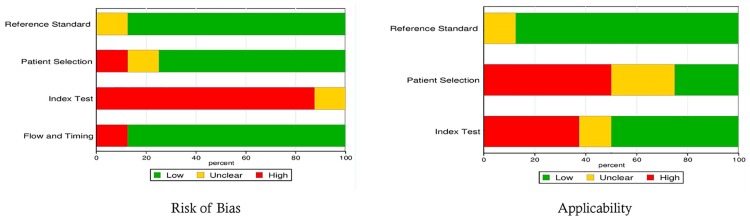
Graphical Display of 8 studies results (QUADAS-2).